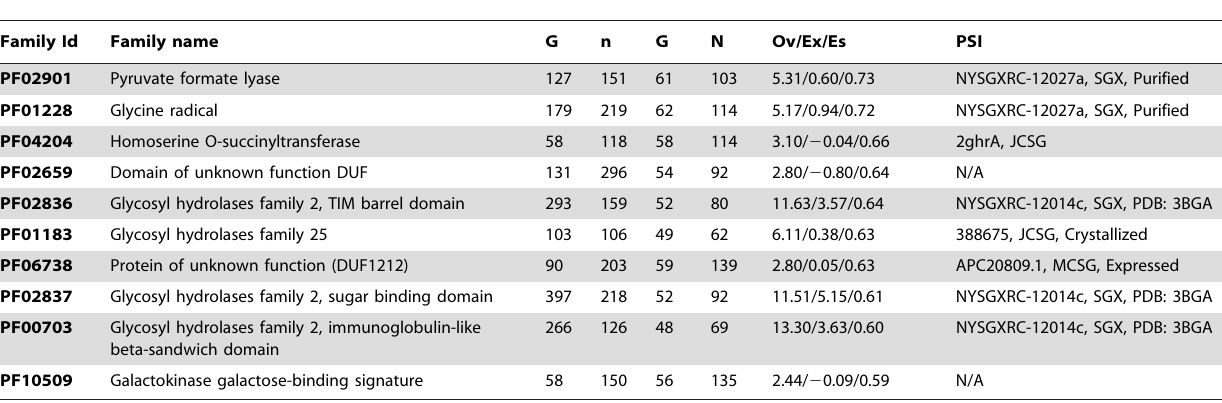
Table 3. The 10 most essential (Es) PfamA families in human gut